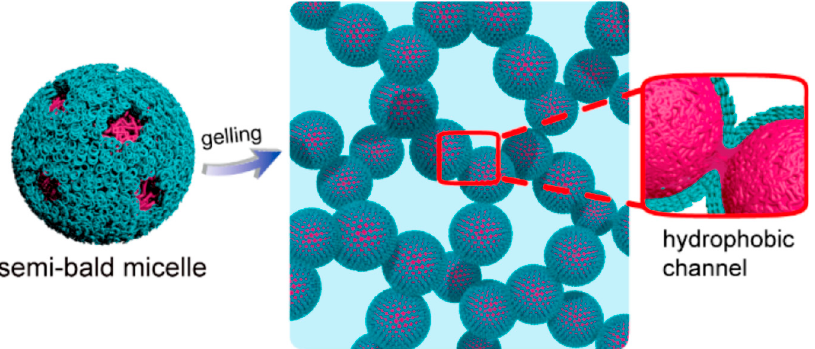
Figure 4. Semi-bald model of PEG/PLGA thermogel. Copyright © 2018, American Chemical Society [66].